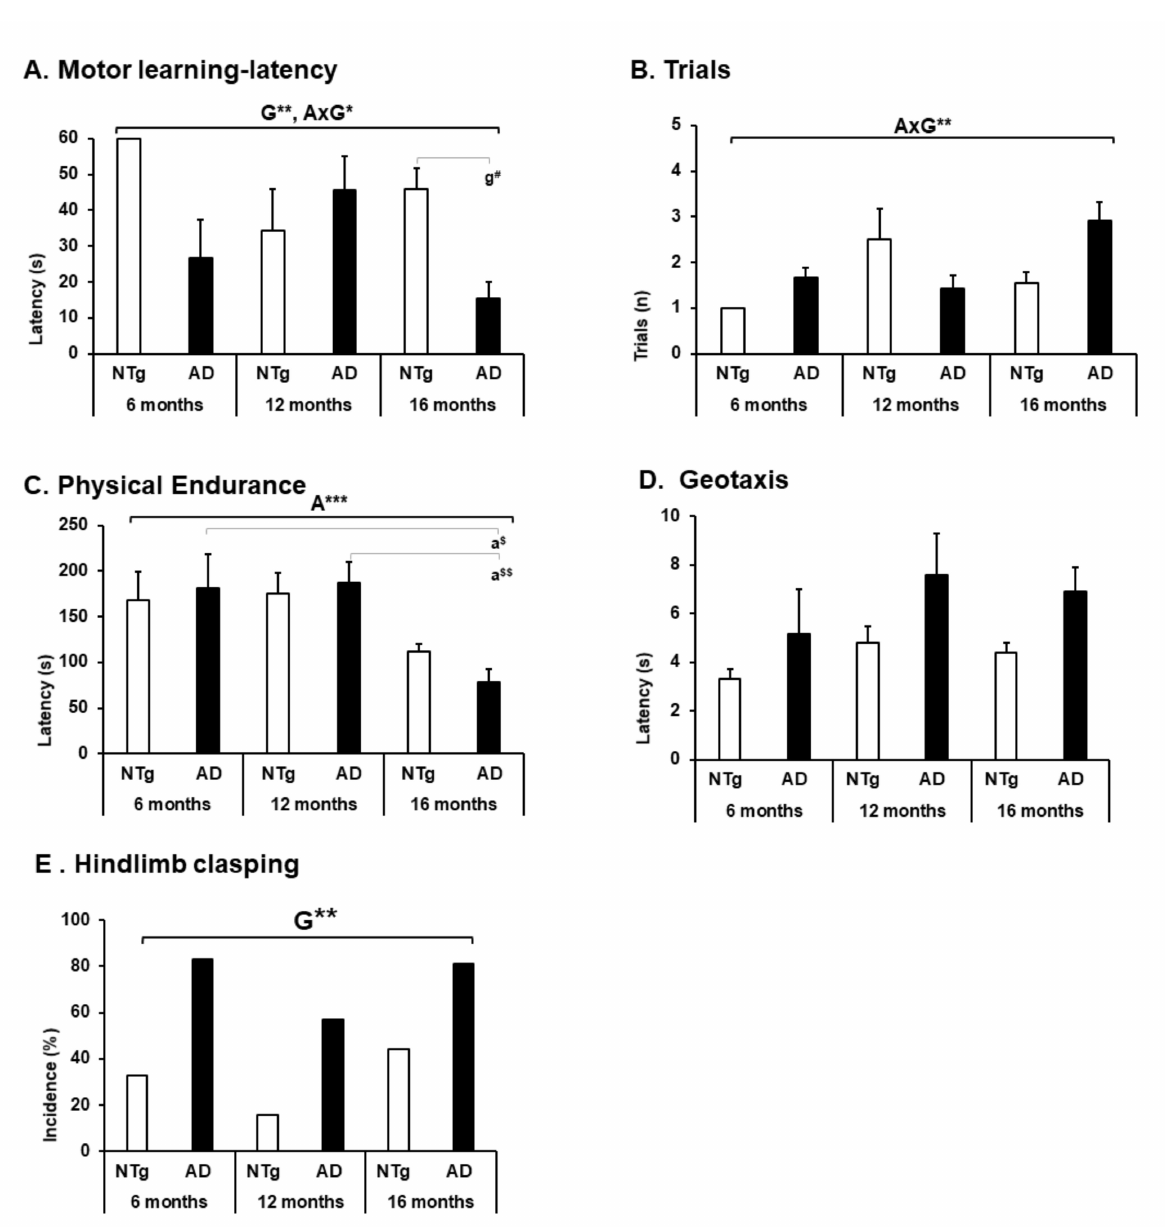
Figure 7. Motor performance, geotaxis and hindlimb clasping. ( A ) Motor learning—latency; ( B ) trials; ( C ) physical endurance; ( D ) geotaxis; the results are expressed as mean ± SEM. Statistics: one-way ANOVA, Age effect expressed as ( A ); Genotype effect expressed as (G); Genotype and Age interaction effect are expressed as (GxA). * p < 0.05, ** p < 0.01, and *** p < 0.001 followed by post hoc Bonferroni test, # p < 0.05; differences between age in 3xTg-AD group are expressed (a): $ p < 0.01, $$ p < 0.01.( E ) Hindlimb clasping; the results are expressed as prevalence (%). Statistics: Fisher’s exact test; Age effect is expressed as (A); Genotype effect is expressed as (G); Genotype,* p <